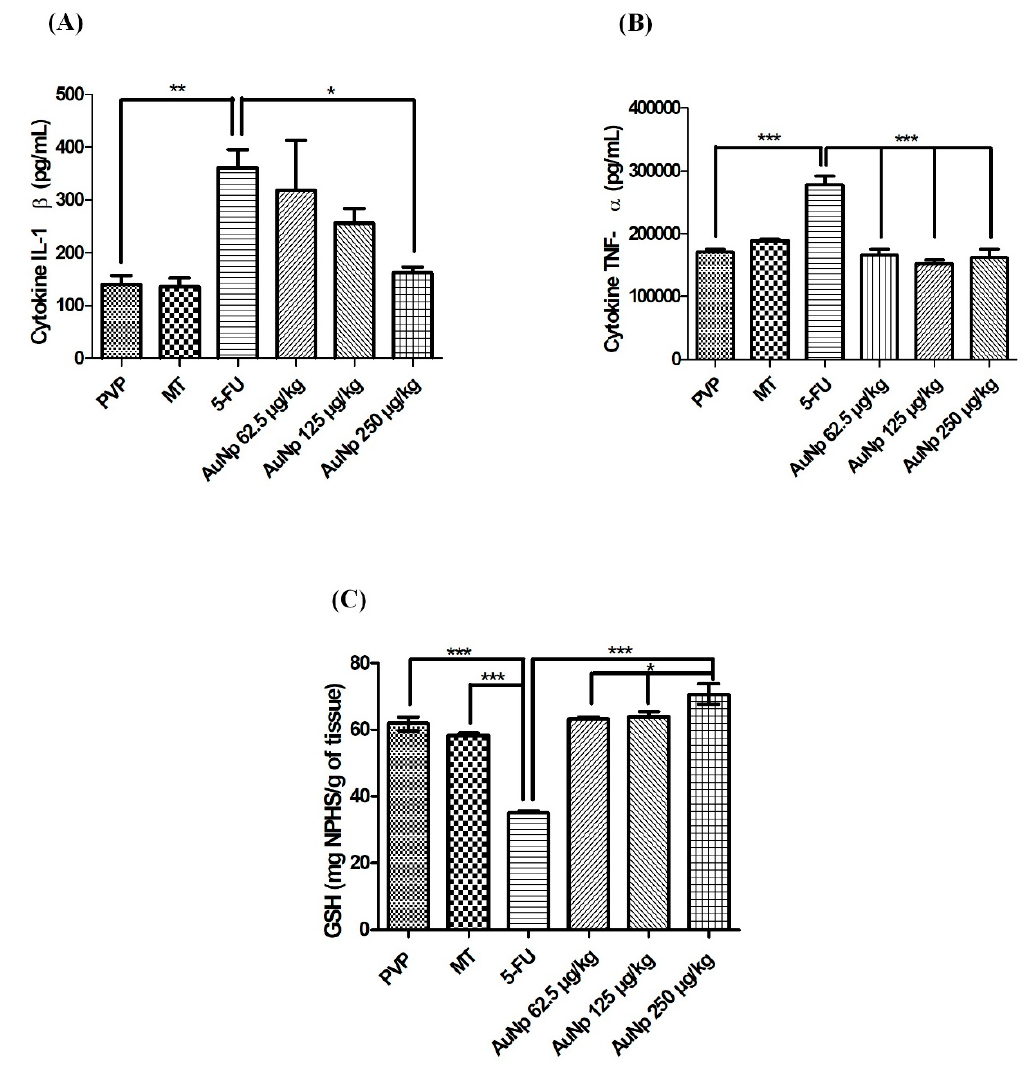
Figure 4. Quantification of interleukin 1 beta (IL)-1 β ( A ), tumor necrosis factor alpha (TNF)- α ( B ), or glutathione (GSH) ( C ) in the oral mucosa on the 10th day of the experimental model of oral mucositis in hamsters. The PVP group: Animals without OM. The mechanical trauma (MT) group: Hamsters that received excoriations on the oral mucositis. The 5-FU group: Animals received 5-FU and were subjected to MT. The AuNp groups received 5-FU, were subjected to MT, and were treated with AuNp (IP) at one of three doses (62.5, 125, or 250 µ g / kg). ( n = 5 / group). The results are presented as the mean ± standard error of the mean, ( n = 5 / group). * p < 0.05; ** p < 0.001; *** p < 0.0001 (analysis of variance with Tukey’s post-test).